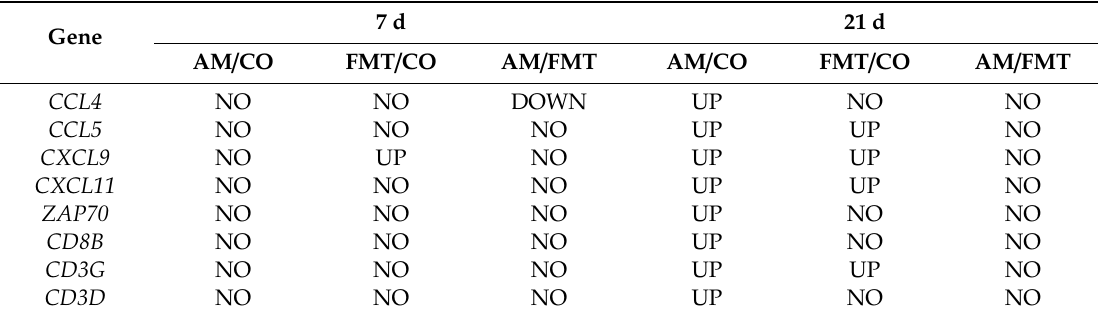
Table 3. Expression of genes related to the toll-like receptor signaling pathway and the T cell receptor signaling pathway in the ileum mucosa of piglets in the amoxicillin (AM), fecal microbiota transplantation (FMT), and control (CO) groups on days 7 and